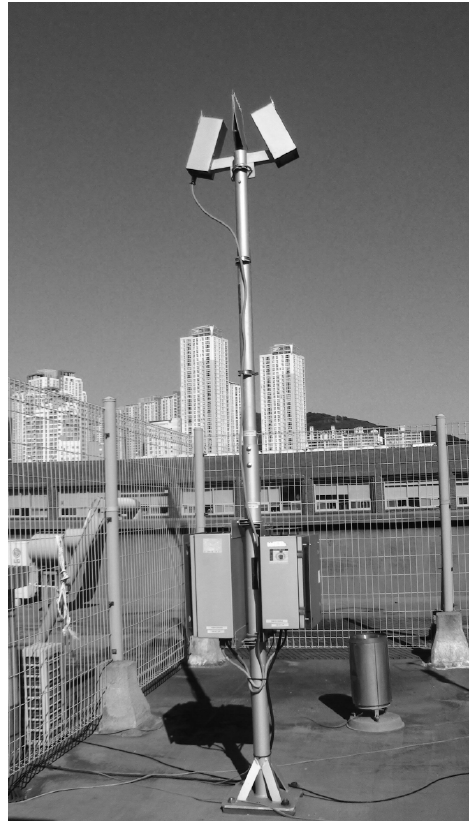
Figure 1. Photograph of the POSS instrument used in this research. Table 1. Specification of the POSS